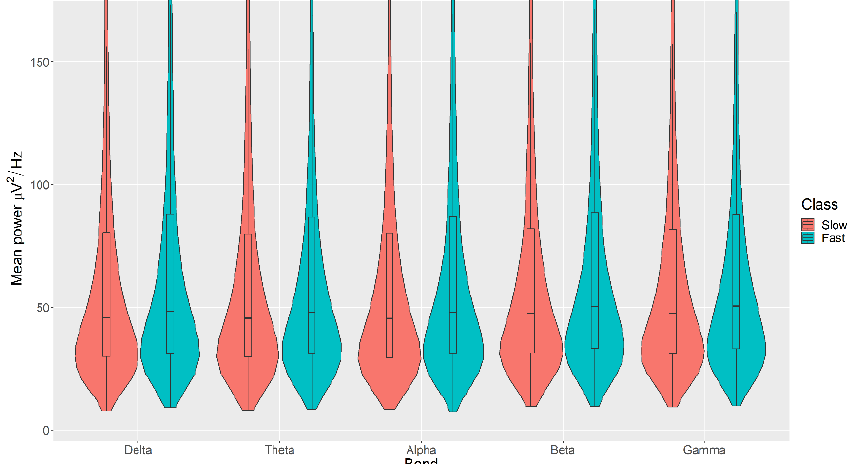
Figure 7. Violin plot of the average power in each of the bands for Slow and Fast categories for the Movement VDEP, ranging from low ( δ delta) to high ( γ gamma) frequencies.